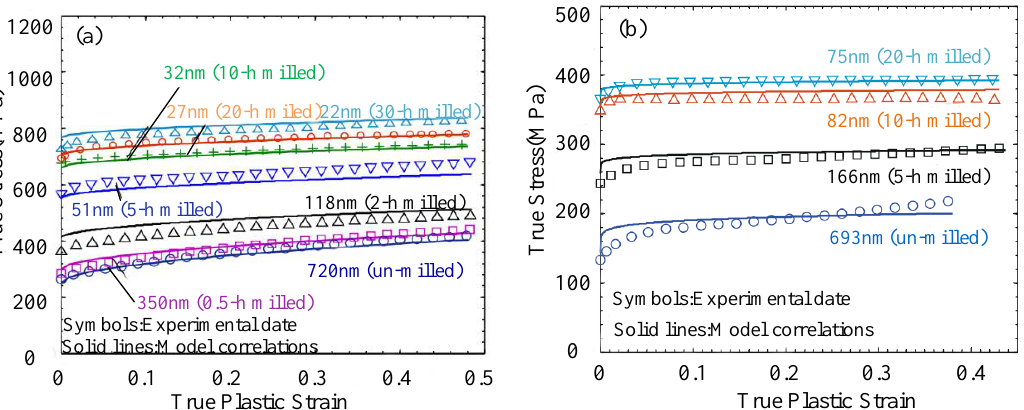
Figure 9. Prediction results of the KLF model under different mean particle sizes [21], ( a ) Cu; ( b )